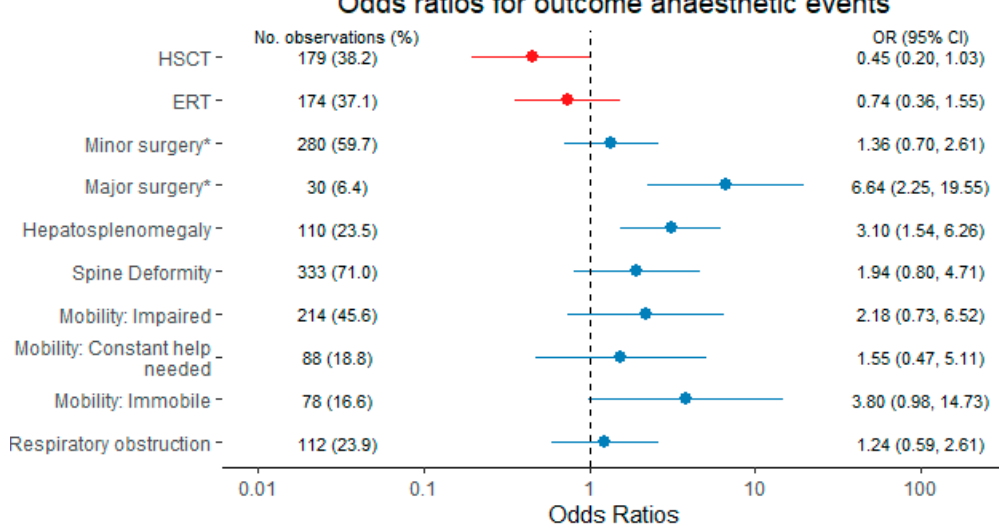
Figure 3. Estimated odds ratios and 95% confidence intervals (CI) for anaesthesia-related complications from a multivariable model based on automatic variable selection via lasso regression. Variables are presented in blue color (increased risk) or red color (decreased risk), respectively. * Reference: diagnostics and interventions. Abbreviations: CI, confidence interval; ERT, enzyme replacement therapy; HSCT, haematopoietic stem cell transplantation.